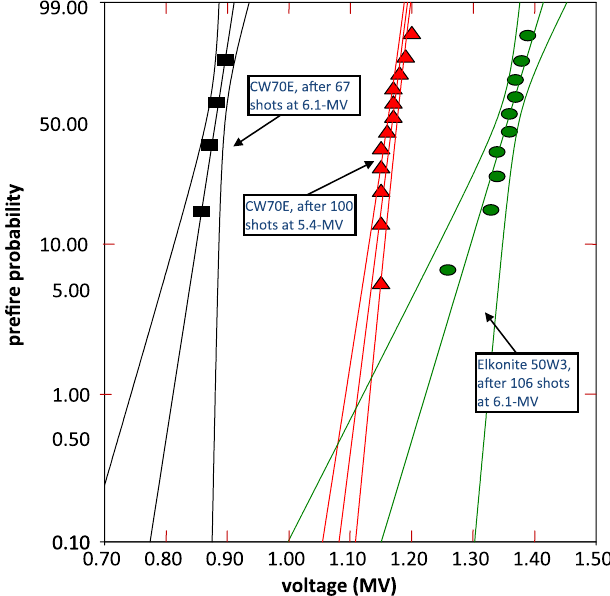
FIG. 7. (Color) Self-break voltage curves for only the gap de- signed to be triggered by the laser at 48-psia for materials CW70E and Elkonite 50W3. This gap accounts for (cid:1) 15% of the total switch voltage when operated under normal operating conditions. The cascade section was electrically shorted out of the circuit to collect this self-break information from only the portion of the switch that is normally triggered. The shots prior to these collected data were conducted at full switch operation under normal conditions. At 5.4-MV there is (cid:1) 0 : 21 - C trans- ferred per shot, (cid:1) 0 : 24 - C is transferred per shot at 6.1-MV. The figure is depicted with 90% confidence bands. The experiments were conducted on Z 20